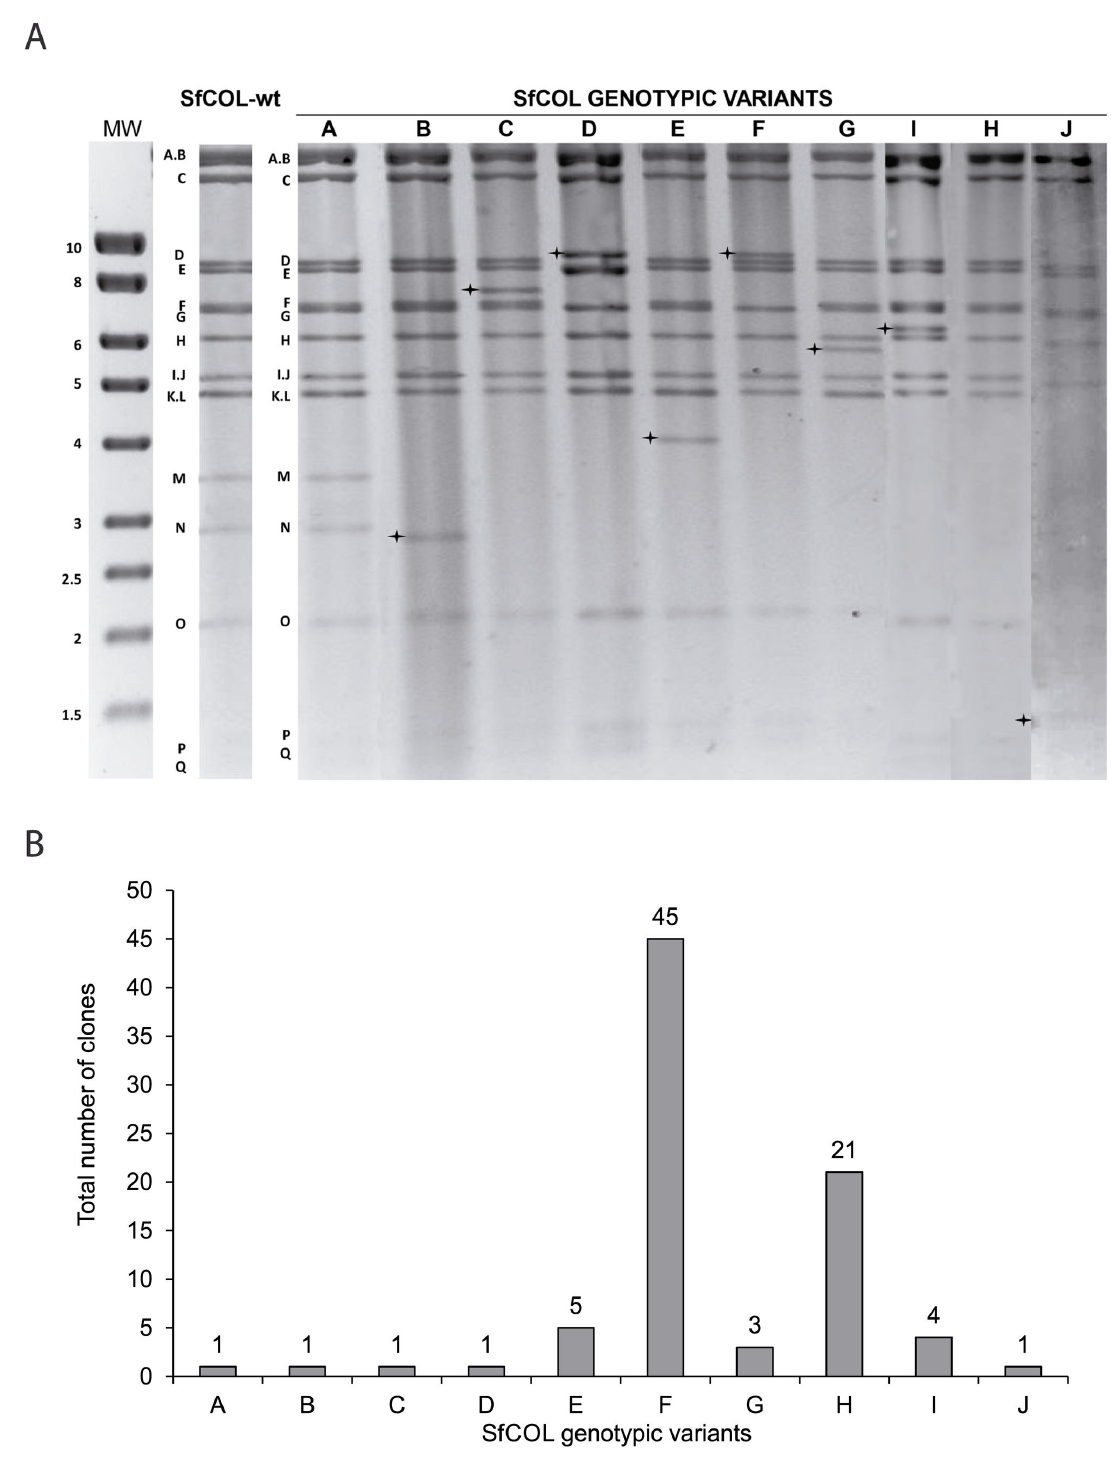
Figure 1. Restriction profiles and frequency of SfCOL genotypic variants. A. REN analysis of SfCOL-wt and genotypic variants DNAs digested with Pst I following electrophoresis in 1% agarose gel. All DNA fragments of SfCOL-wt and SfCOL-A are marked with a letter corresponding to their sizes. The cross marks the polymorphic fragments of each variant. The first lane indicates the molecular weight (MW) (1Kb DNA marker, Stratagene). B. Number of clones obtained for each of the genotypes (total number of clones 83). doi: 10.1371/journal.pone.0077271.g001 PLOS ONE |